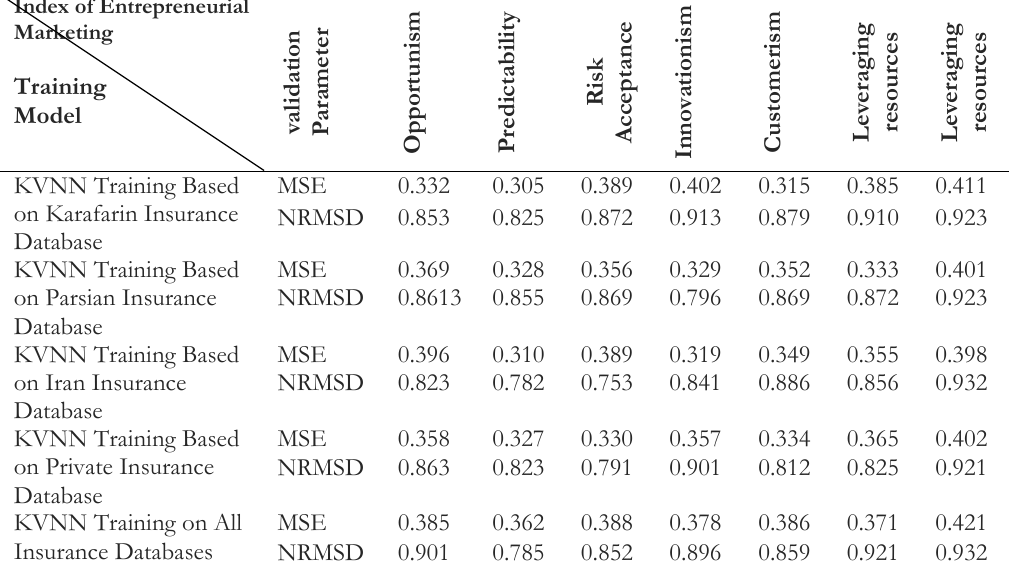
Table 4. Predicting entrepreneurial marketing indexes and organizational structure with proposed algorithm in five different